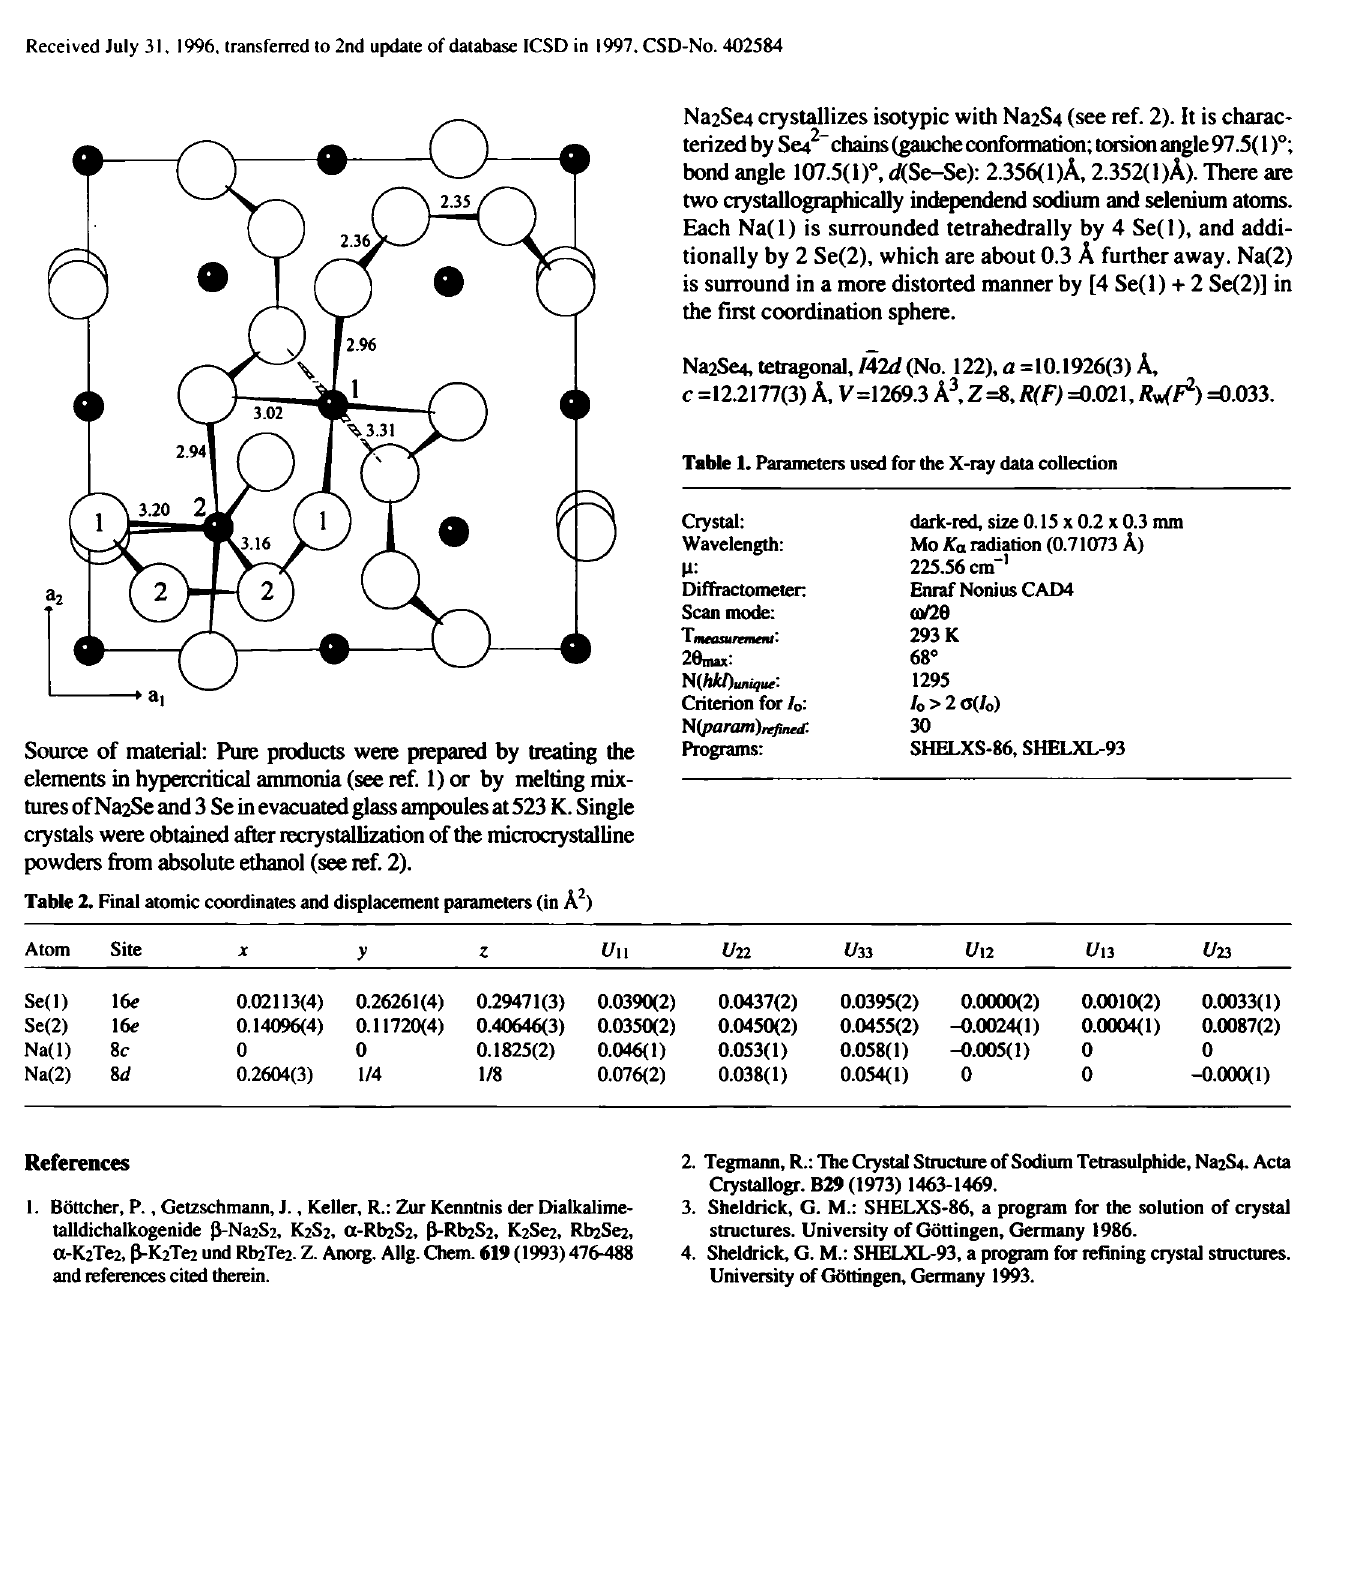
Table 2. Final atomic coordinates and displacement parameters (in Â 2 ) Atom Site